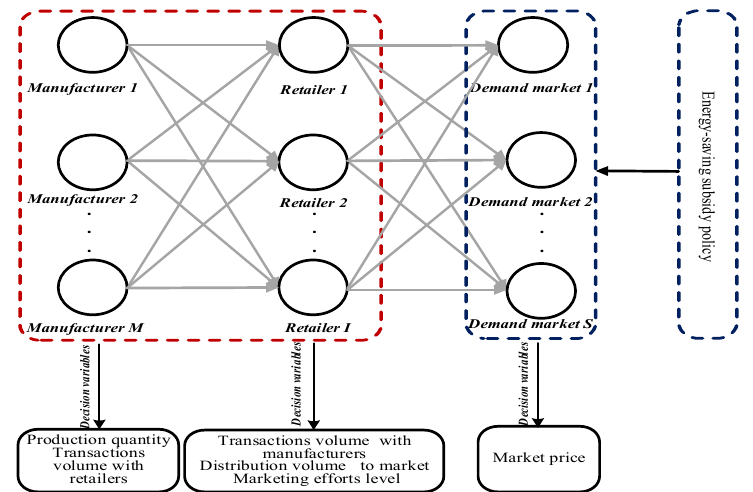
Energies 2022 , 15 , x FOR PEER REVIEW